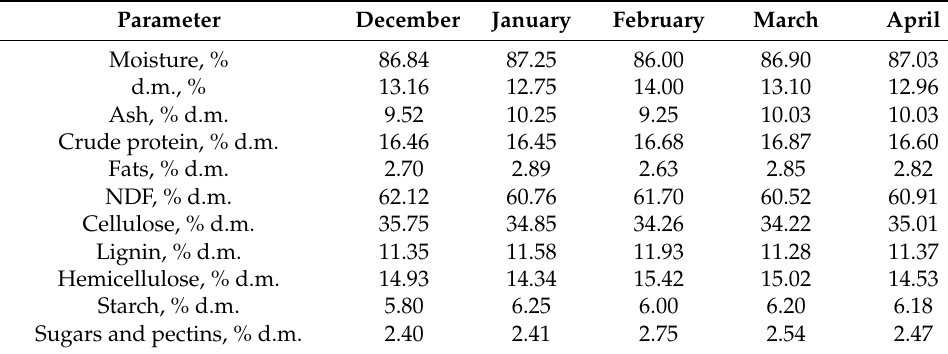
Table 7. Analysis of the composition of the Treatment feces, done with the portable NIR instru- ment Polispec.